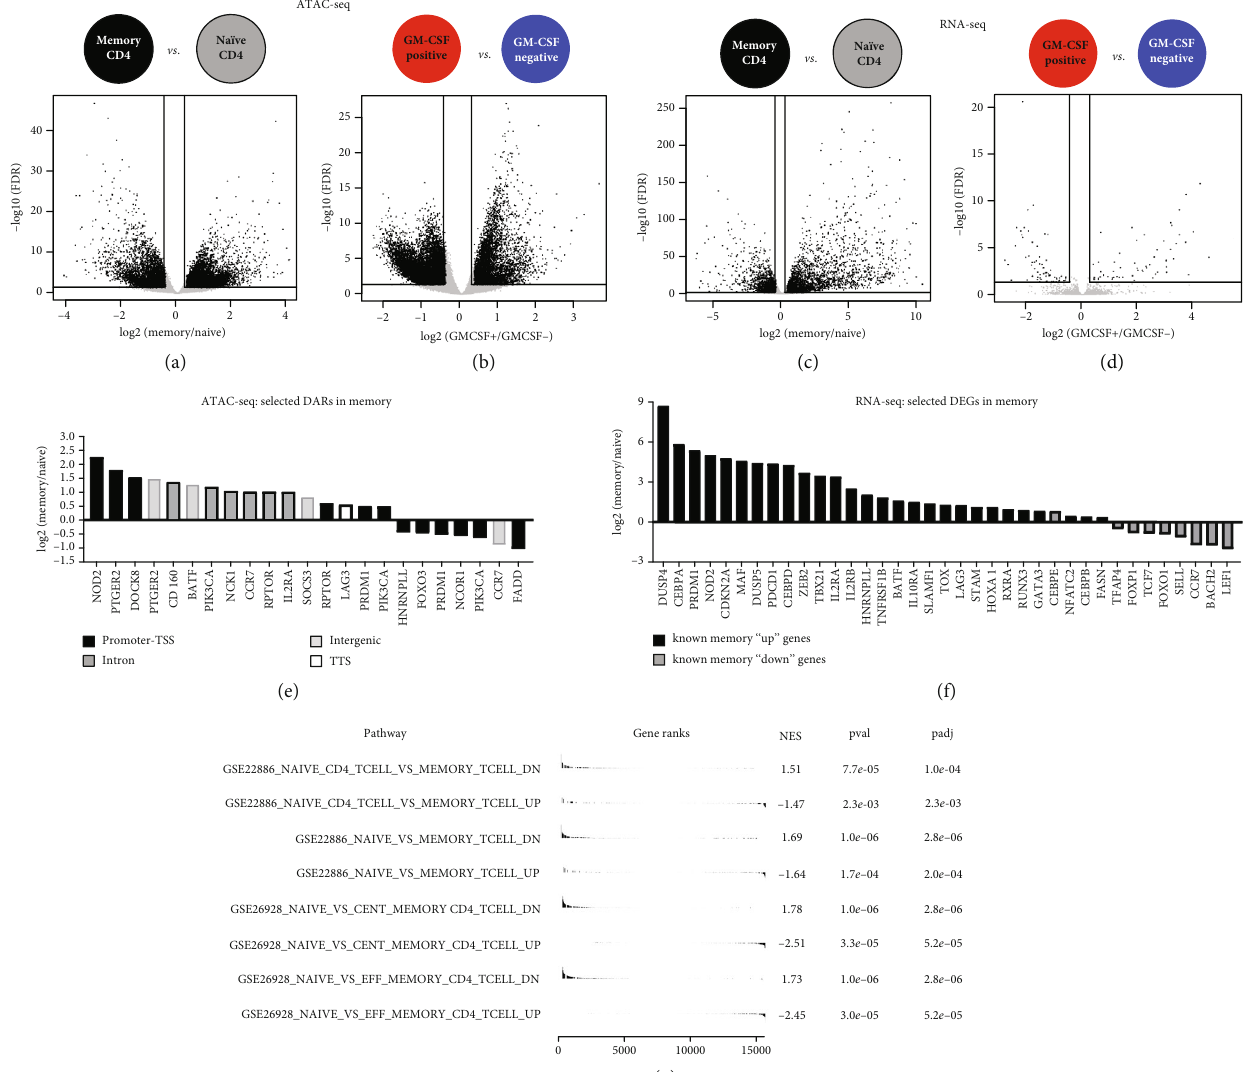
Figure 3: Di ff erential chromatin accessibility and gene expression in memory versus naïve CD4 T cells as well as in GM-CSF-positive versus negative cells. (a, b) ATAC-seq data were CQN normalized and di ff erential accessibility between the indicated cell population comparisons was calculated ((a) memory vs. naïve CD4 T cells; (b) GM-CSF-positive vs. negative CD4 T cells). Volcano plots show each consensus peak as a single dot, and lines indicate the threshold for calling a DAR ( FDR < 0 : 05 and > 25% fold change); DARs are depicted in black. (c, d) Di ff erential gene expression was calculated from RNA-seq data for cell population comparisons as in (a, b). Lines indicate the threshold for calling a DEG ( FDR < 0 : 05 and > 25% fold change); DEGs are depicted in black. (e) A selection of DARs in memory vs. naïve was studied for being assigned to genes known to play a role in T cell memory. log (fold change (memory/naïve)) for selected DARs are 2 plotted, and colors indicate the category that the respective region is assigned to (TSS: transcription start site; TTS: transcription termination site). (f) Known T cell memory “ up ” (black) or T cell memory “ down ” (grey) genes based on previous literature were selected if di ff erentially expressed (DEG in memory vs. naïve) in the present data. log (fold change (memory/naïve)) for these selected DEGs is 2 plotted; values > 0 represent upregulation and values < 0 represent downregulation in memory T cells. Colors indicate whether the gene was previously described to be “ up ” or “ down ” in memory T cells. (g) Gene set enrichment analysis (GSEA) using gene sets from published transcriptome data featuring naïve and memory T cell subsets (GSE accession numbers as displayed) and a ranked gene list of ð P value Þ × sign ð log our memory versus naïve T cell data. Ranking was based on − log (fold change (memory/naïve))). Gene sets 10 2 containing both human naïve and memory T cell data were retrieved from the MSigDB database [48]. NES: normalized enrichment score; pval: P value; padj: